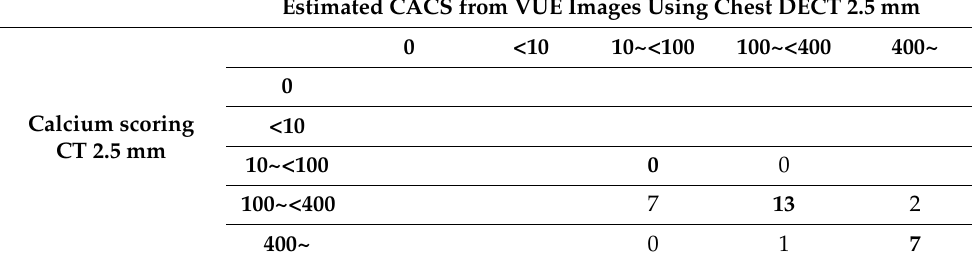
Table 7. Sectional analysis of CACS of CT and estimated CACS from VUE images using chest DECT with 2.5 mm slice thickness and the first-order linear regression